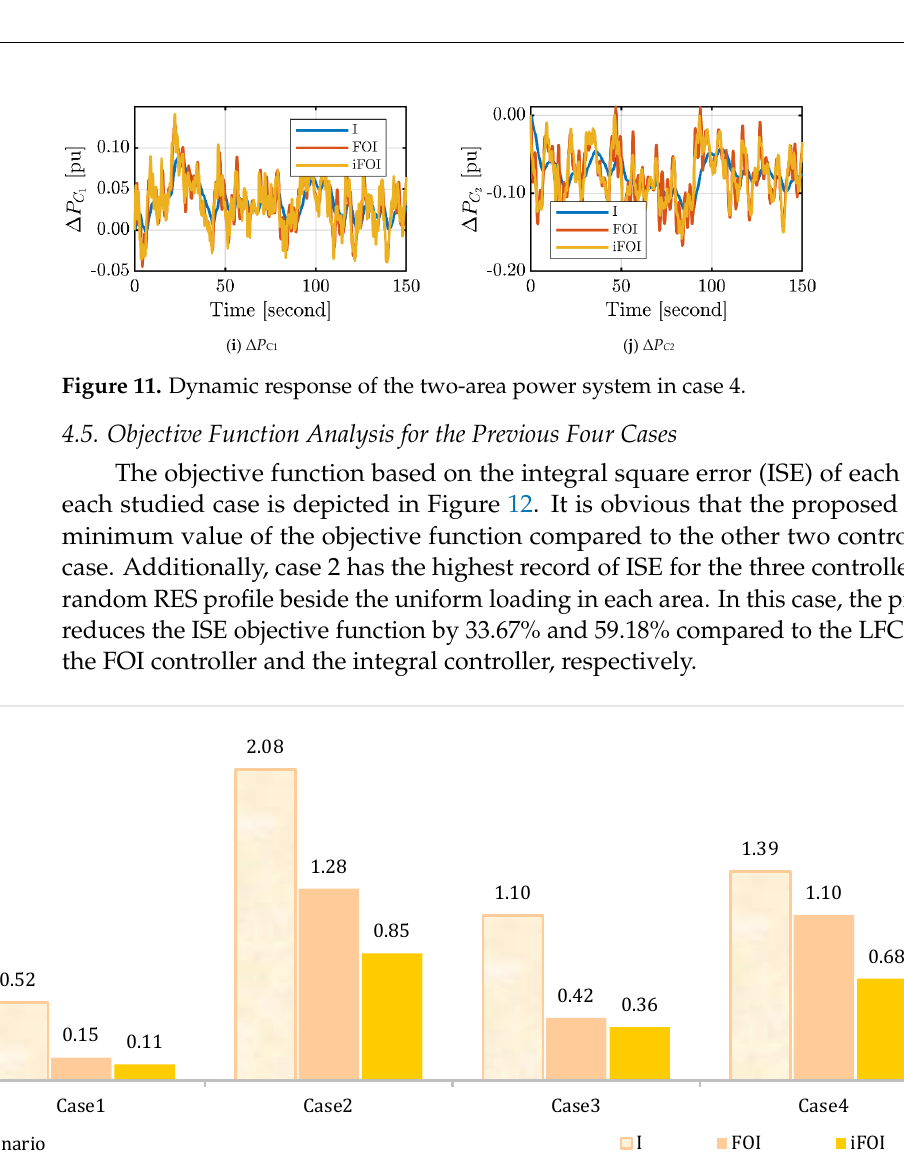
Figure 12. Evaluation of the objective function of each controller for each studied case.